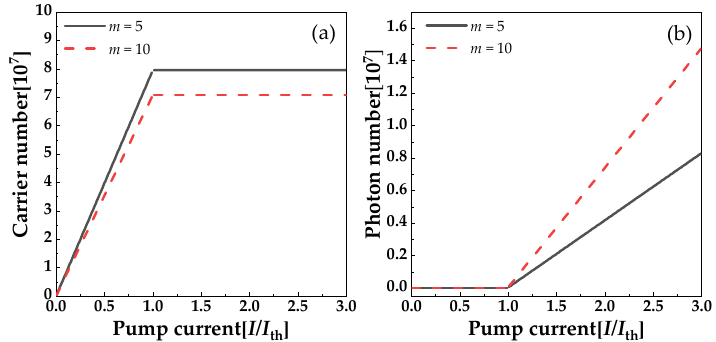
Figure 2. ( a ) Carrier number and ( b ) photon number vs. pump current. Black solid and red dashed curves represent stage numbers m = 5 and m = 10, respectively.